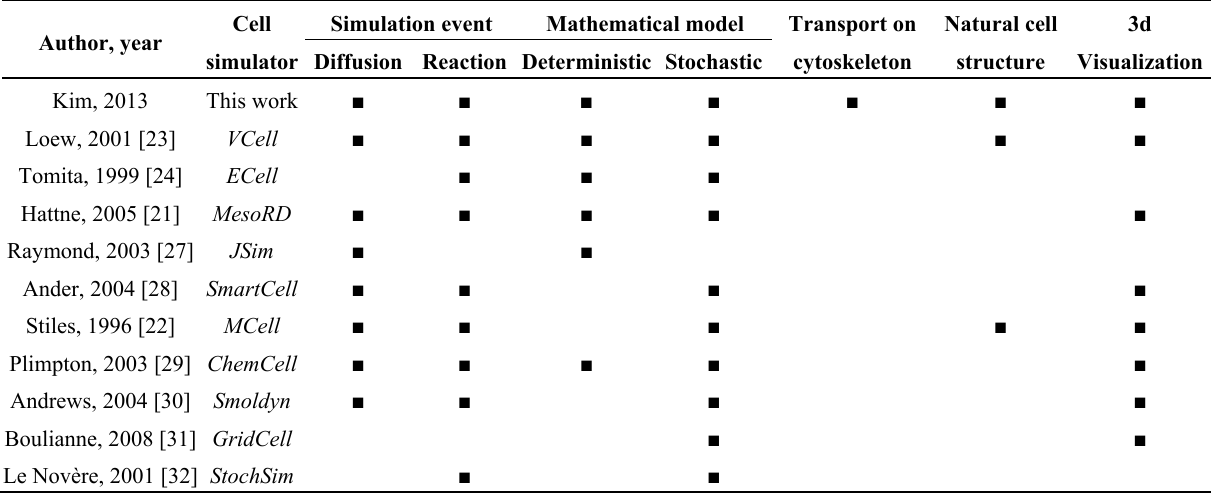
Table 1. Overview of cell